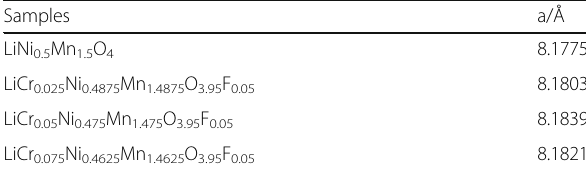
Table 1 Refinement results for the samples Samples a/Å